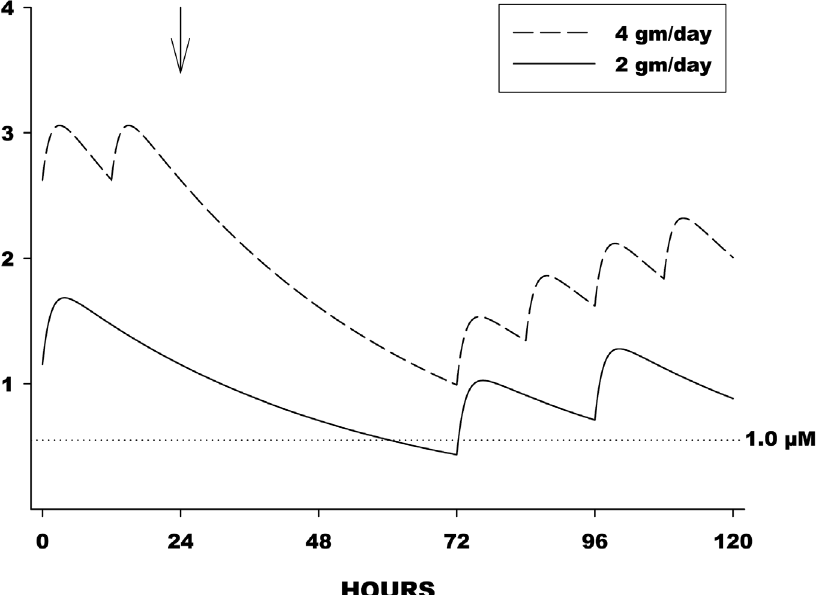
Figure 3. Effect of Drug Holiday on CSF Drug Levels. Predictive illustration of the effect of ‘‘drug holidays’’ at steady-state. Drug holiday began at the arrow (24 hours). Dosing then resumed as usual at 72 hours. Despite the holiday, CSF levels remained above 1 micromolar in the 4 gm/day group, and fell slightly below 1 micromolar in the 2 gm/day group. doi:10.1371/journal.pone.0061177.g003 PLOS ONE |